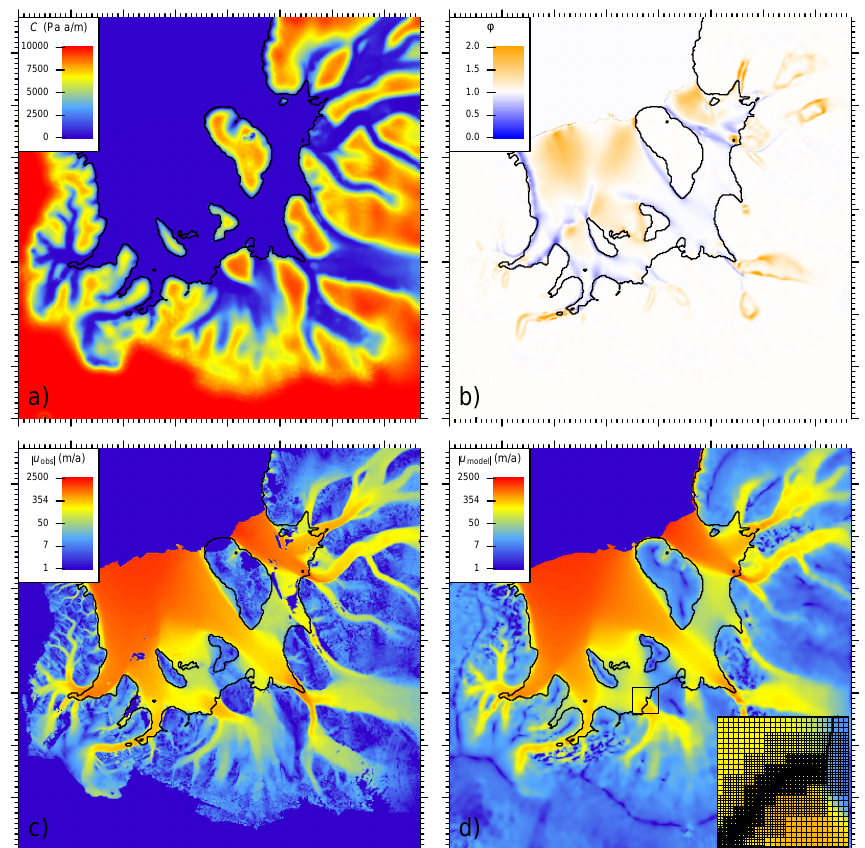
Figure 2. Results of the inverse problem after 16 iterations for (a) the basal traction parameter C (red is “sticky”; blue is “slippery”), (b) the effective viscosity factor φ , (c) observed surface velocity and (d) modelled velocity from the start of the reference run. In each case the initial location of the grounding line for all forward simulations is shown in black.